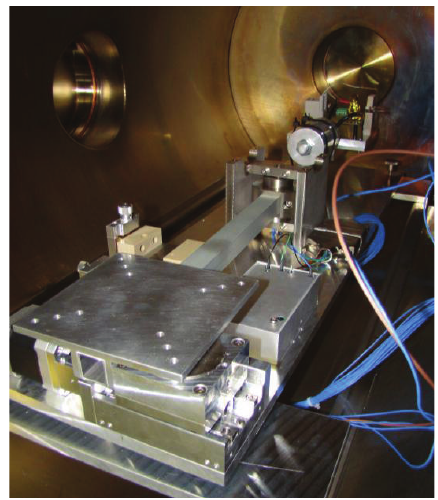
Figure 9: Micro-Newton thrust